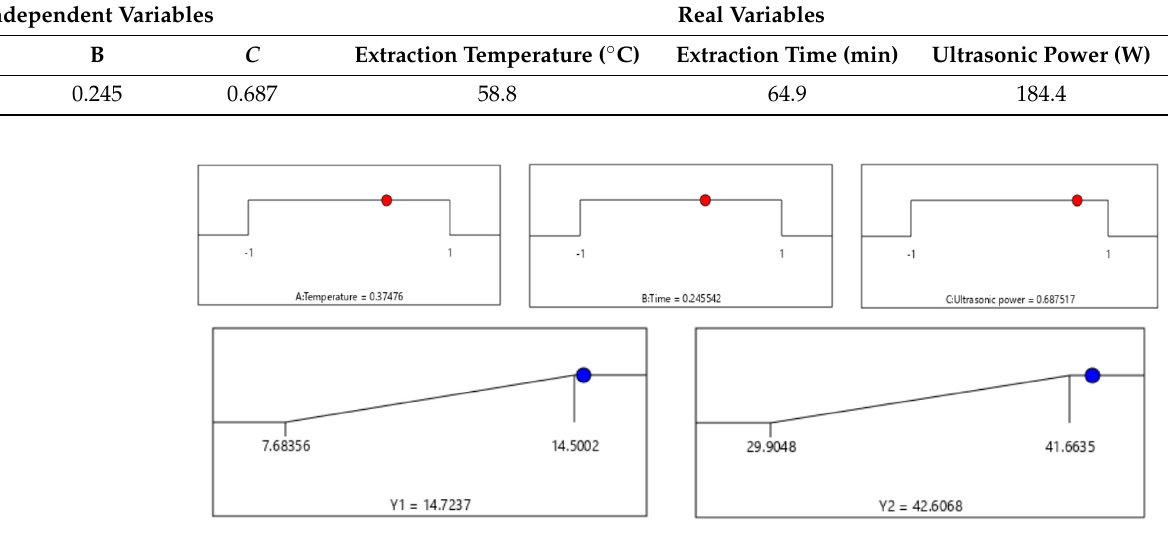
Figure 4. Optimal conditions by the solution of ramps.